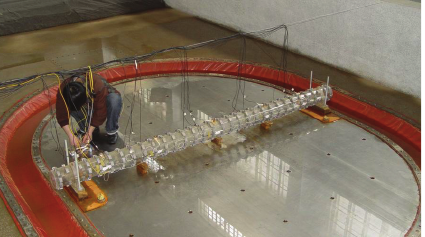
Figure 3: Underwater shaking table and submarine pipeline model in